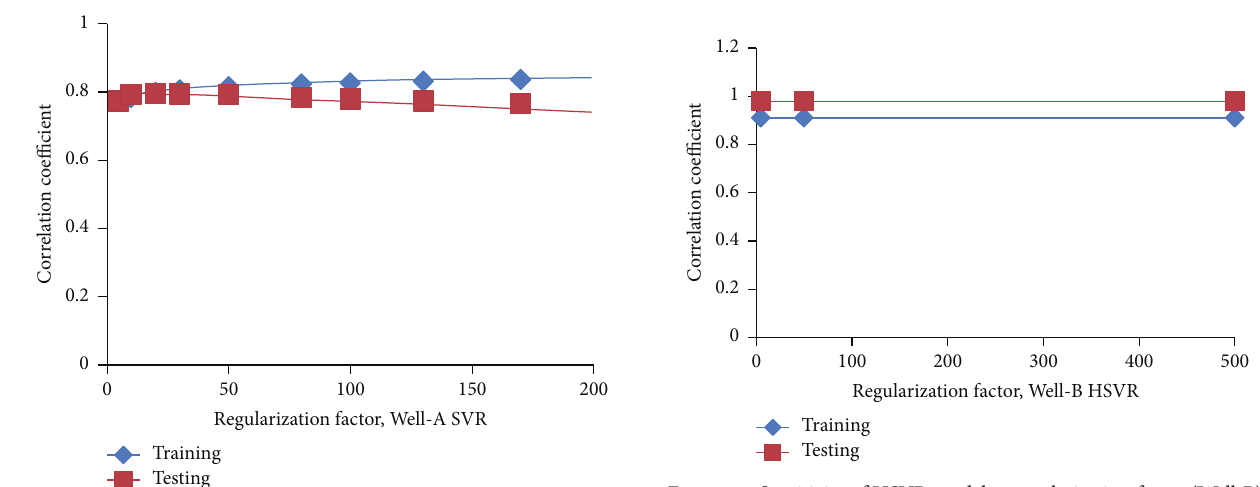
Figure 7: Sensitivity of HSVR model to regularization factor (Well-B).